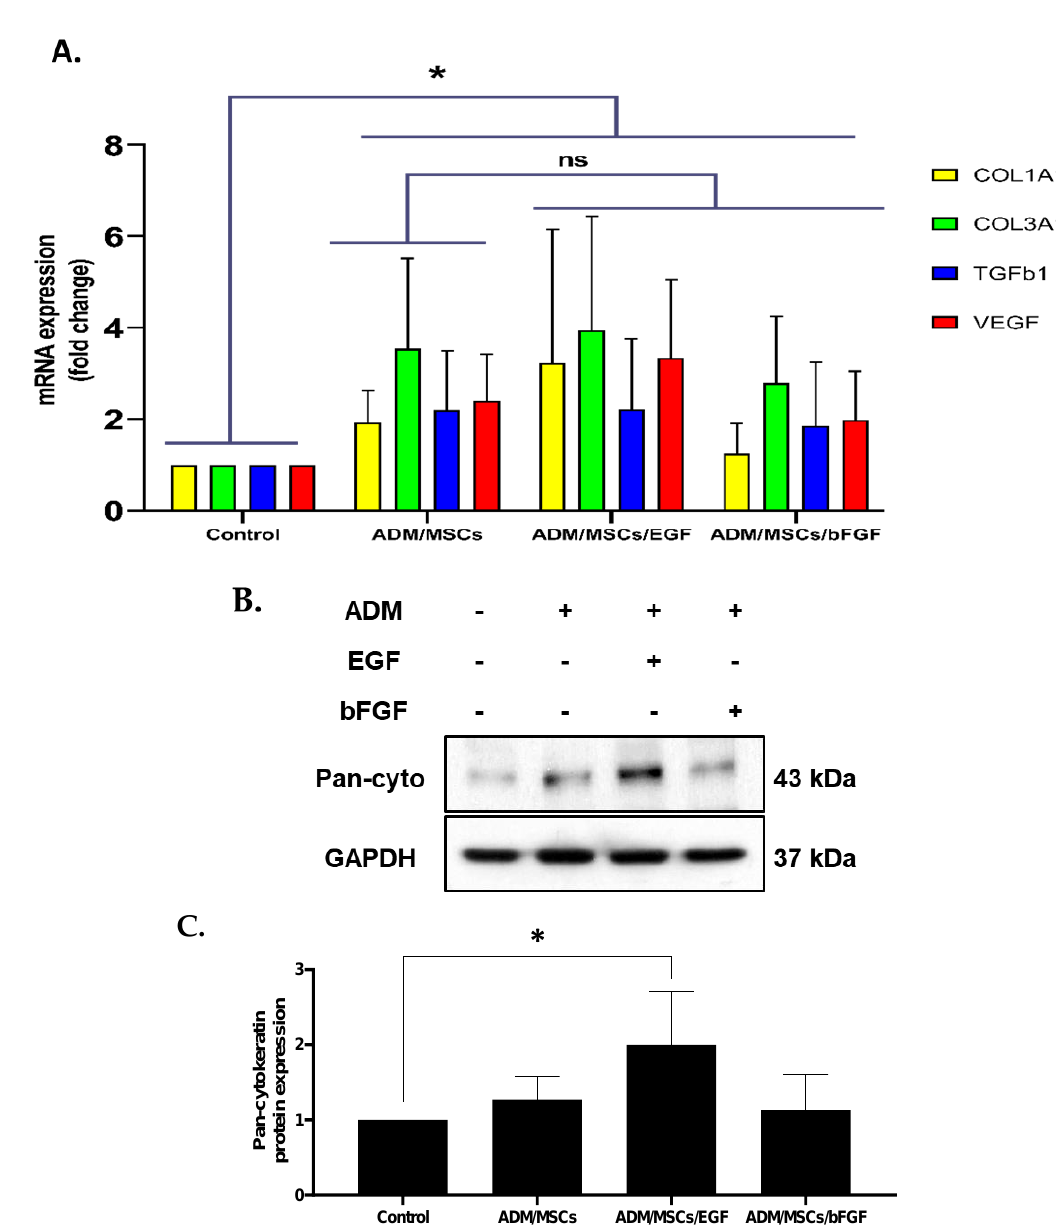
Figure 3. ( A ) Expression levels of mRNA markers for tympanic membrane regeneration. The gene expression of Col1A1, Col3A1, TGFb1 and VEGF in the experimental group was significantly higher than that of the control group (ADM). Although, there was no statistical significance, EGF treated group (ADM/MSC/EGF) showed the highest expression level of collagen and VEGF. COL1A1: Collagen type I alpha 1, COL3A1: Collagen type III alpha 1, TGFb1: Transforming growth factor-beta, VEGF: Vascular endothelial growth factor, ( B , C ) Immunoblot showing the expression of pan-cytokeratin. Among three experimental groups, the ADM/MSC/EGF group showed significantly higher expression compared to the control group. Image processing was carried out using Image J. (* p < 0.05, n = 6), ns = not significant explanation.